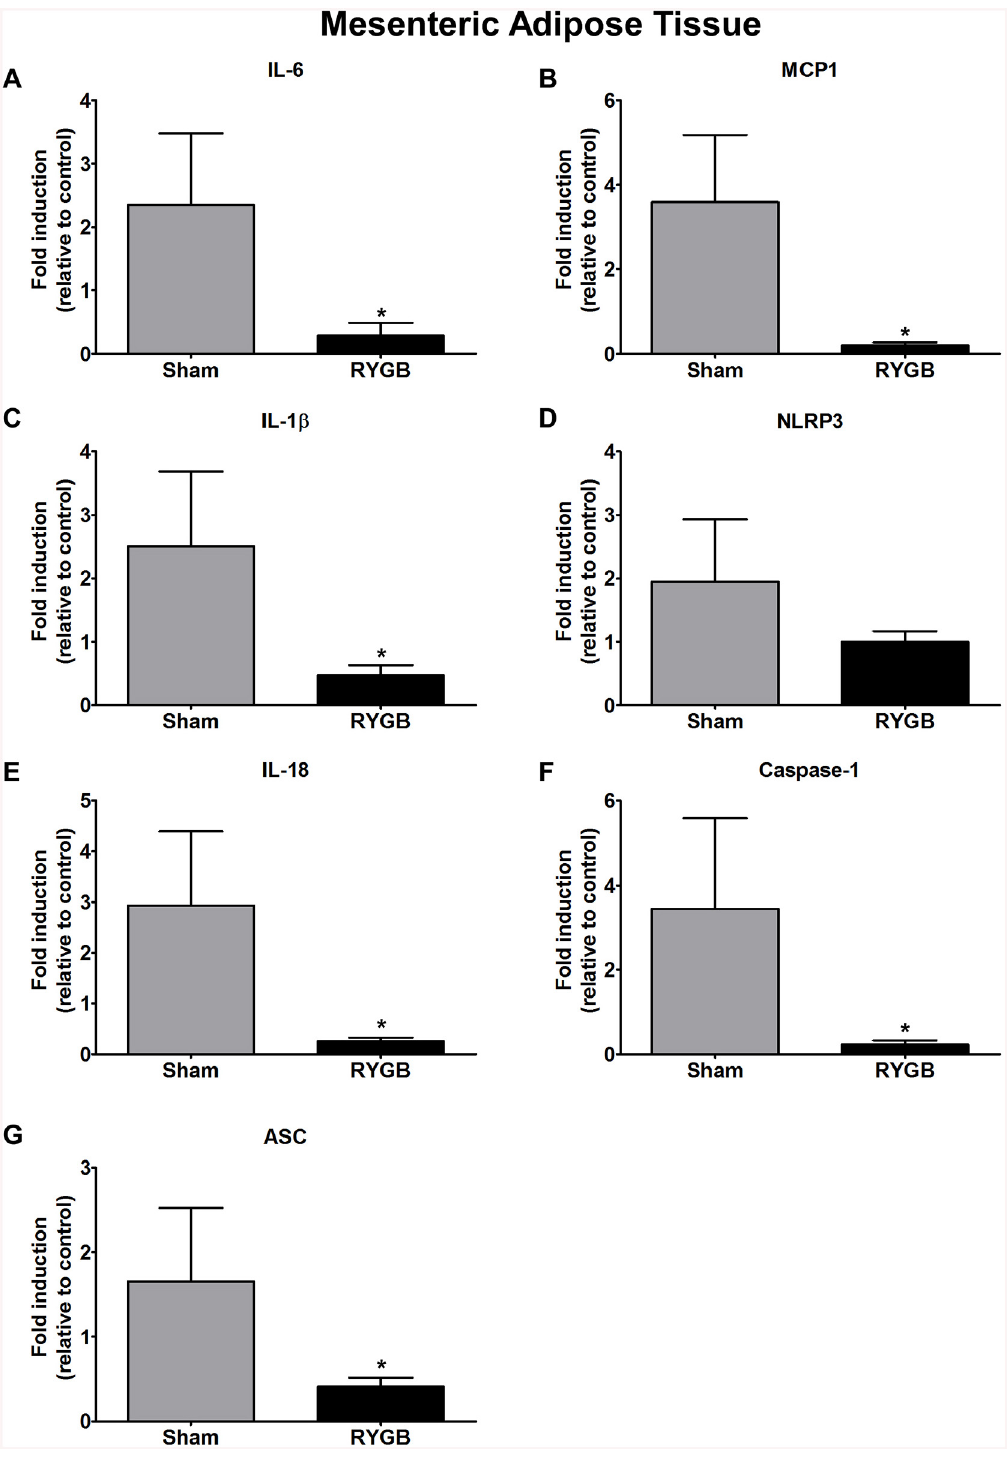
Fig 3. The expression of IL – 6 (A), MCP – 1 (B), IL – 1 β (C), NLRP3 (D), IL – 18 (E), caspase – 1 (F) and ASC (G) genes in mesenteric adipose tissue between sham and RYGB groups. N = 8 (control) and N = 8 (RYGB). Data are mean ± SE. * denotes a significant difference between Sham control vs.